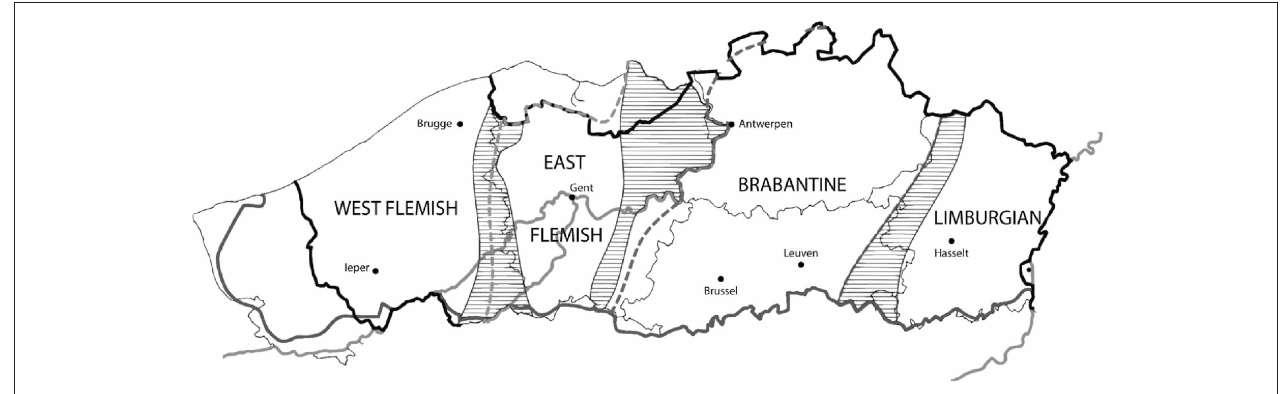
FIGURE 1 | Dialect areas traditionally distinguished in Flanders (based on Taeldeman, 2009, p. 359).